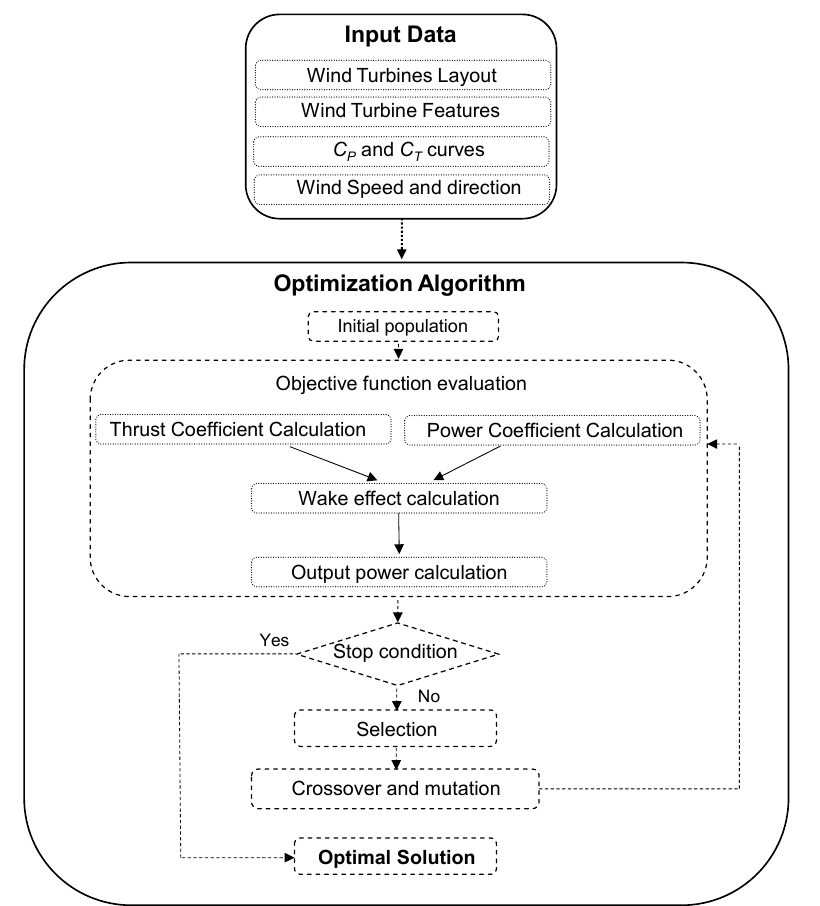
Figure 4. Flowchart of the proposed methodology.